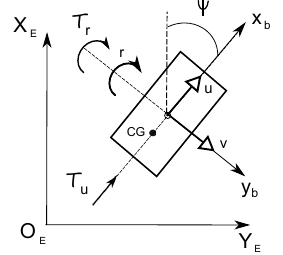
Figure 1. Marine vehicle model